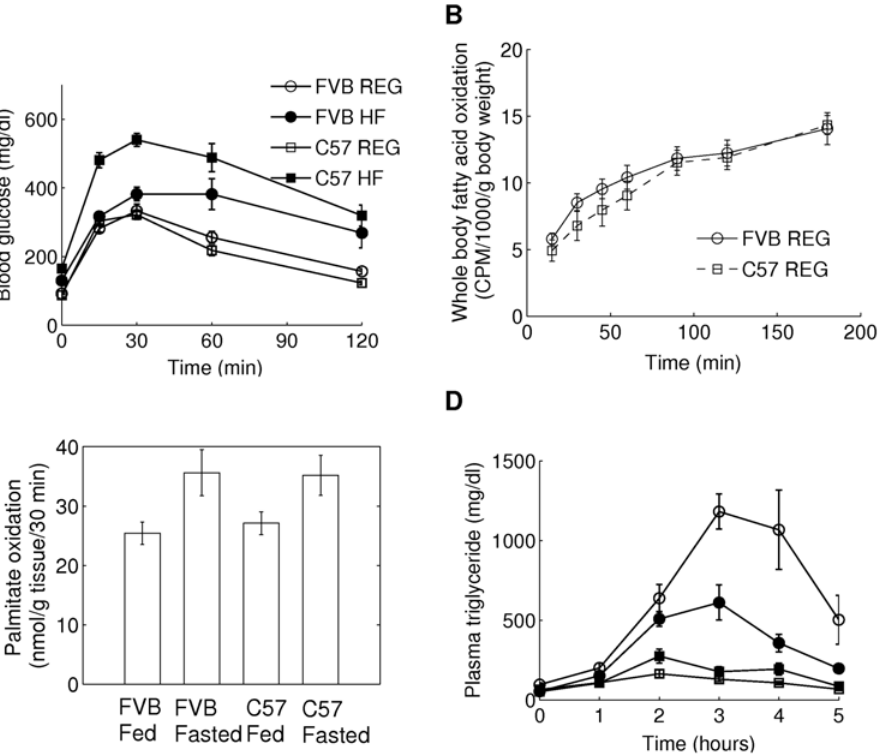
Figure 2. Physiological characteristics of FVB and C57 mice. (A) Glucose tolerance test was performed on week 10 of controlled feeding with chow and high-fat diet. Mice were fasted overnight and injected with glucose (2 mg/g, i.p.). Each group was represented by 8 mice. (B) Whole body oxidation of oleic acid was measured 10-week old male FVB ad C57 mice in non-fasted state (8 mice per group) as described in Gautam et al. [47]. (C) Oxidation in palmitic acids was measured in soleus muscle dissected from 10-week-old FVB and C57 mice maintained on chow diet (8 mice per group). Samples were collected at 8 am from randomly fed mice or mice fasted for 18 hours [methods in Toyoshima et al. [46]]. (D) Triglyceride clearance in FVB and C57 male mice after 11 weeks of controlled feeding with chow and high fat diet. Mice were fasted for 4 h and then given 400 m l of peanut oil by a gavage. Plasma was collected hourly for 5 h from the tail vein for triglyceride measurement. Each group was represented by 8 mice.